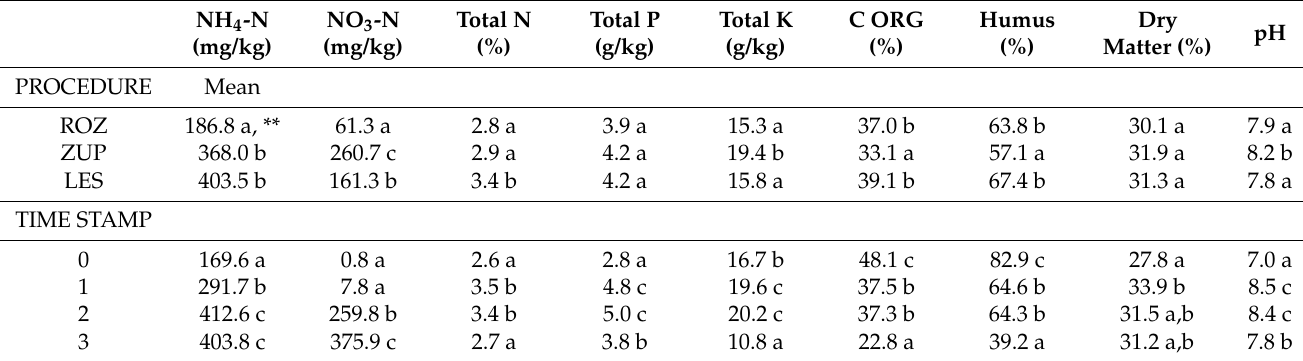
Table 4. Mean nutrient content in piles (procedure) and time